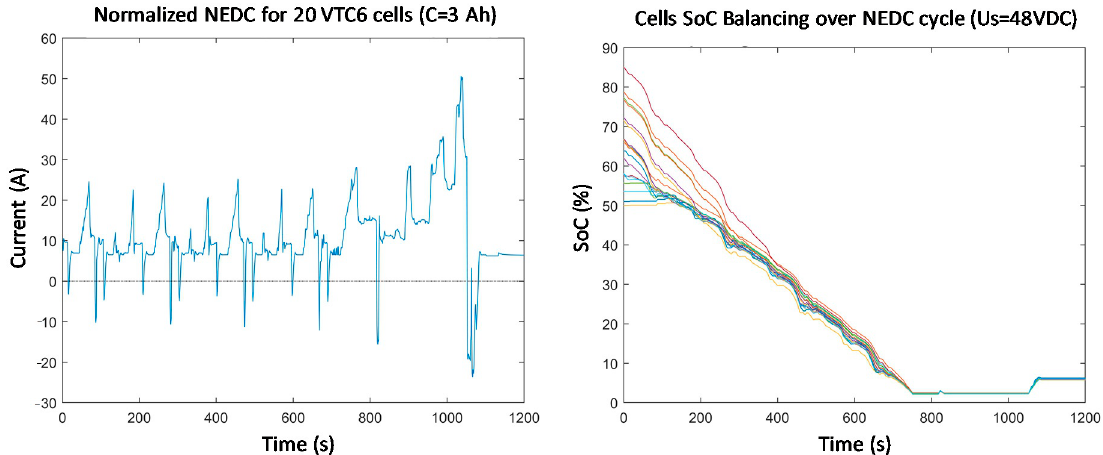
Figure 9. SoC dispersion balancing with New European Driving Cycle (NEDC) profile.